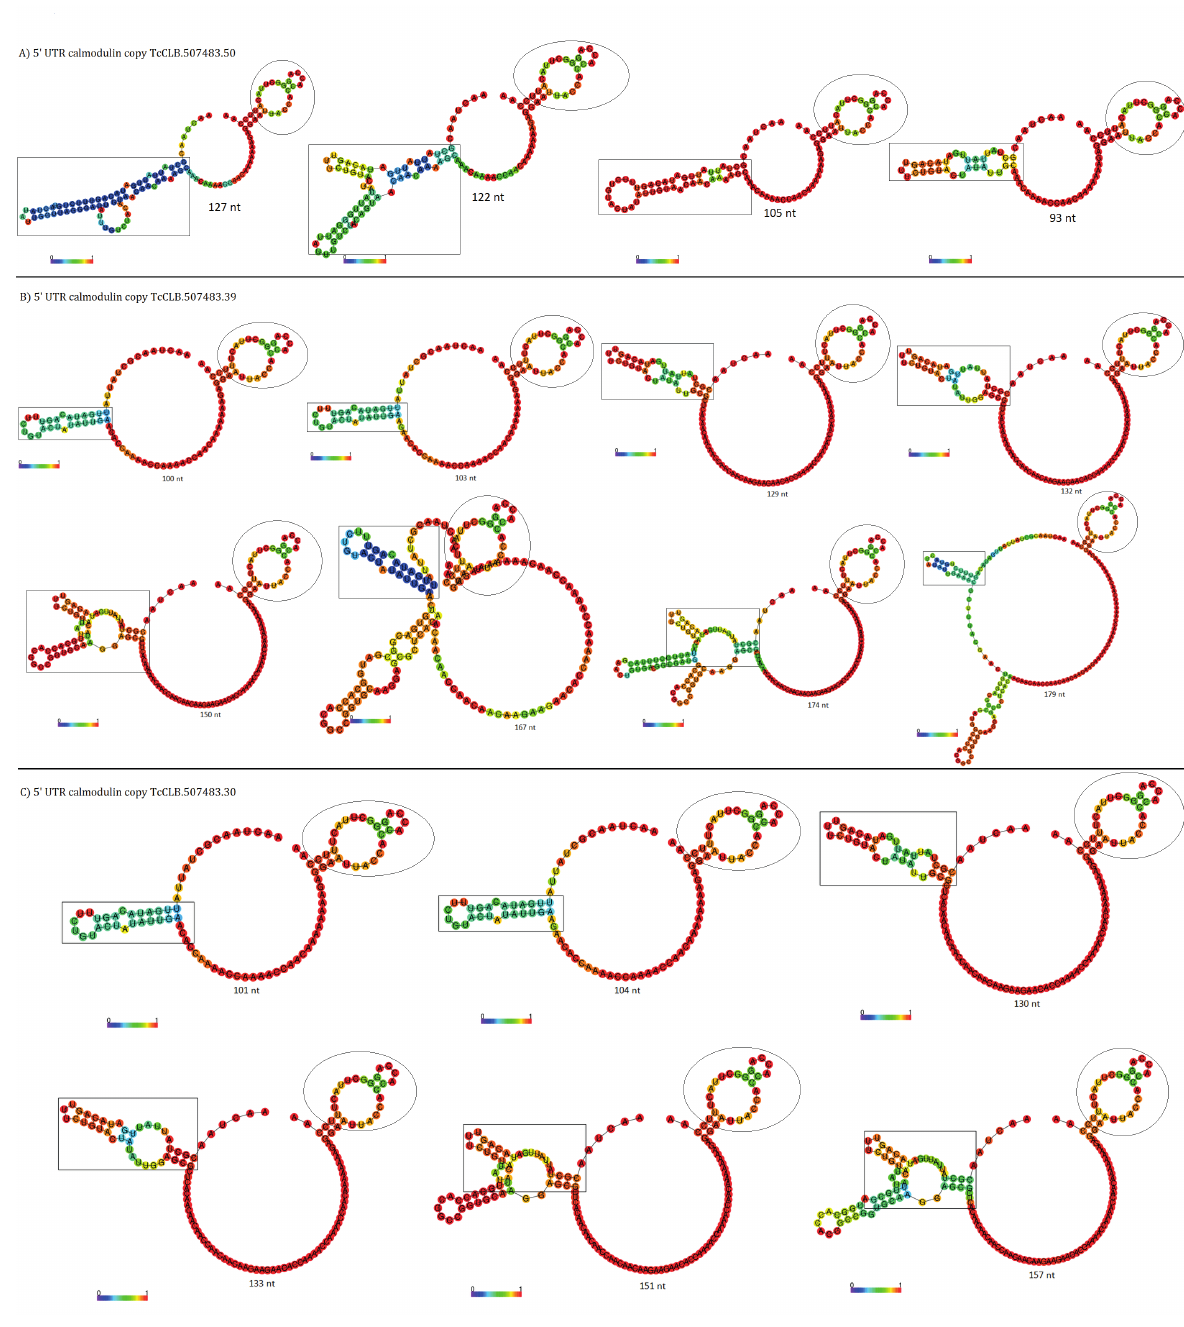
Figure 3 - Predicted mfe structure with base pairing probabilities for the calmodulin 5’ UTR in T. cruzi epimastigote. The 5’ UTR sequences (grouped by copy origin) were joined to 39 nt SL (black line rectangle showing partially paired segment) and folded by RNAfold. Colors in the schematic structure refer to probability of base pairing or unpairing (remaining as single base). Red segments contain the paired (or unpaired) bases of the highest probability. Inside the black line rectangle are the paired bases that the 39 nt spliced leader forms with either itself or the 5’ UTR sequence. Most of these SL paired bases are of low probability. Black line circles indicate the stem loop with high probability paired bases near the start codon of the calmodulin mRNA. Numbers below the major single base segment denote the 5’ UTR length (plus the spliced